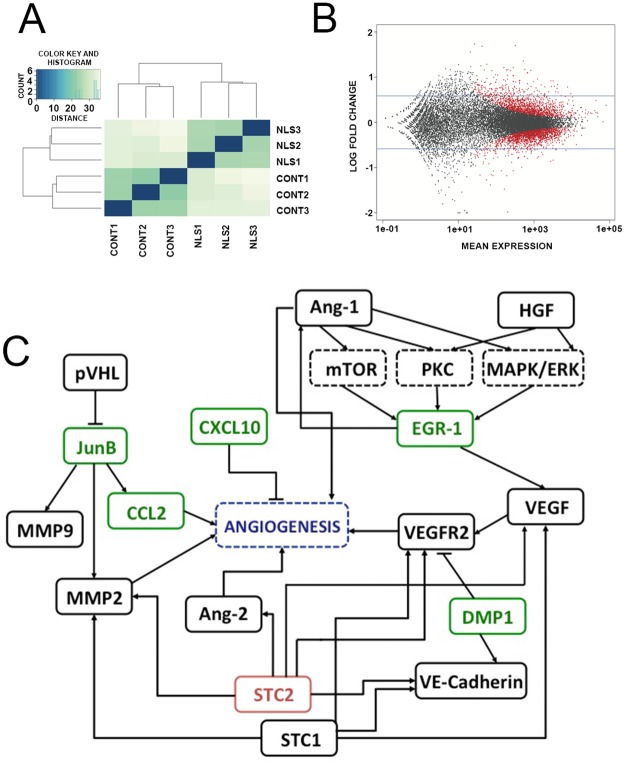
Nuclear IP3 buffering alters the expression of angiogenic related genes.(A) Euclidian distances between samples of both groups: control (CONT1, CONT2 and CONT3 samples) and IP3-sponge-NLS (NLS1, NLS2 and NLS3 samples). (B) Detection of genes differentially expressed. Blue horizontal lines represent the fold change expression cut off (2x fold change or 1 in Log2 scale). Each point represents a single gene of the reference transcriptome. The red points correspond to genes significantly differentially expressed (p<0.01 versus control). (C) Representative pathway indicates indirect existing relationships between differentially expressed genes that are both regulated by nuclear Ca+2 and involved in angiogenic processes. Rectangles represent genes products; green rectangles indicate upregulated genes and red rectangles, downregulated genes. Arrowheads represent activation and T-bars represent repression. Black dashed rectangles indicate signaling pathways and blue dashed lines represent the concept of angiogenesis.